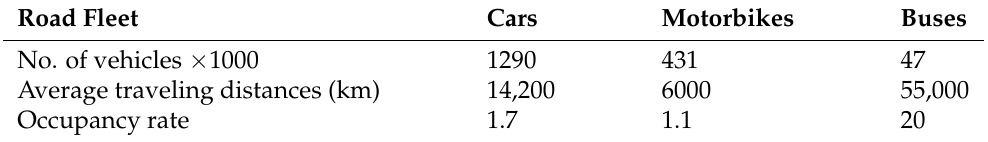
Table 4. Passenger Transport Characteristics.